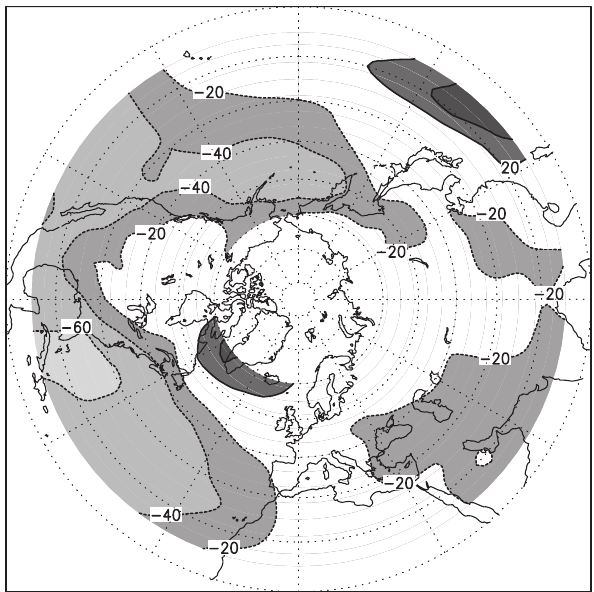
Fig. 4. Correlations (in %) between the tropical SST time series (fig. 2b) and gridded observations of MSLP on the Northern Hemisphere north of 15 °